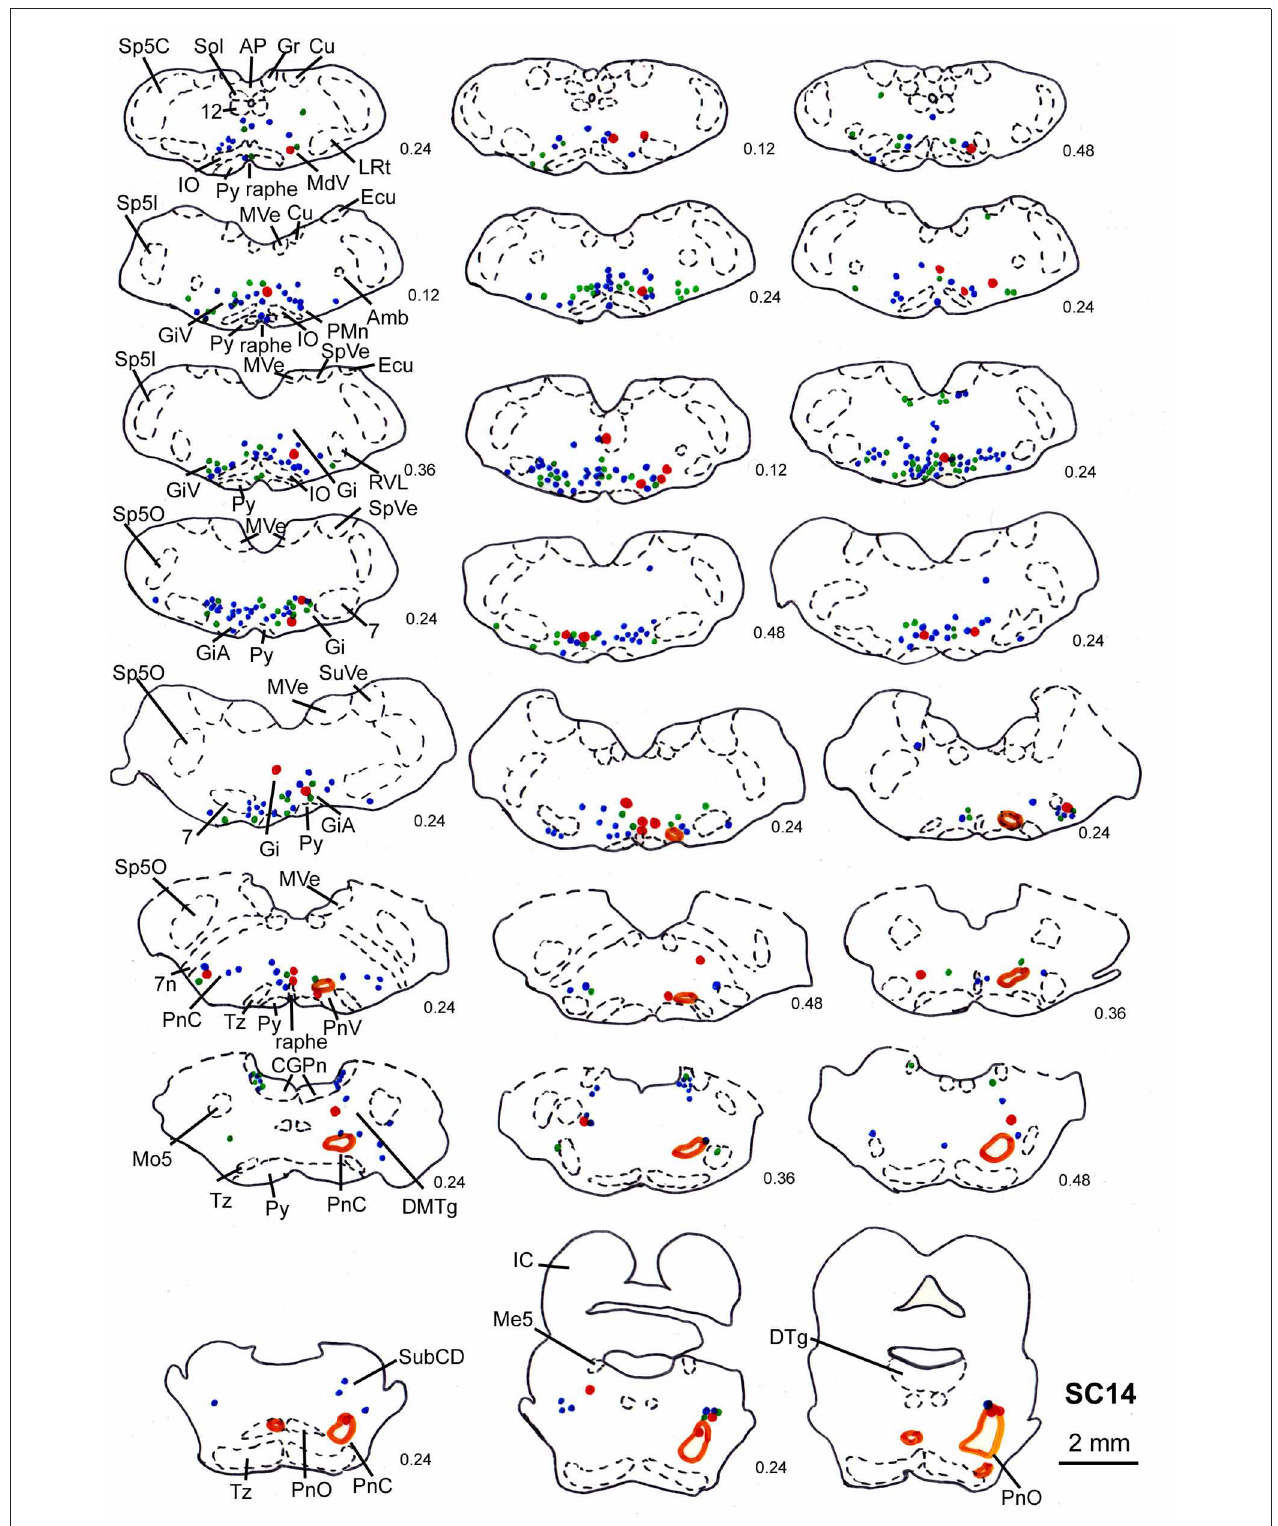
FIGURE 9 | Series of frontal sections through the brainstem and midbrain of case SC14 showing retrogradely labeled neurons after virus injection into the left m. acromiodeltoideusand the left m. rhomboideus,